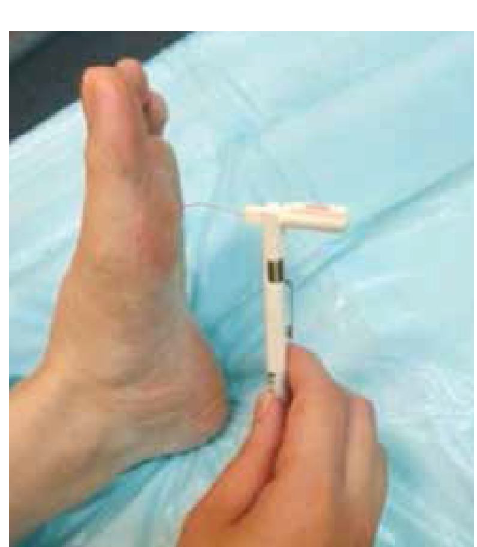
Figure 7. Ten grams of force applied until